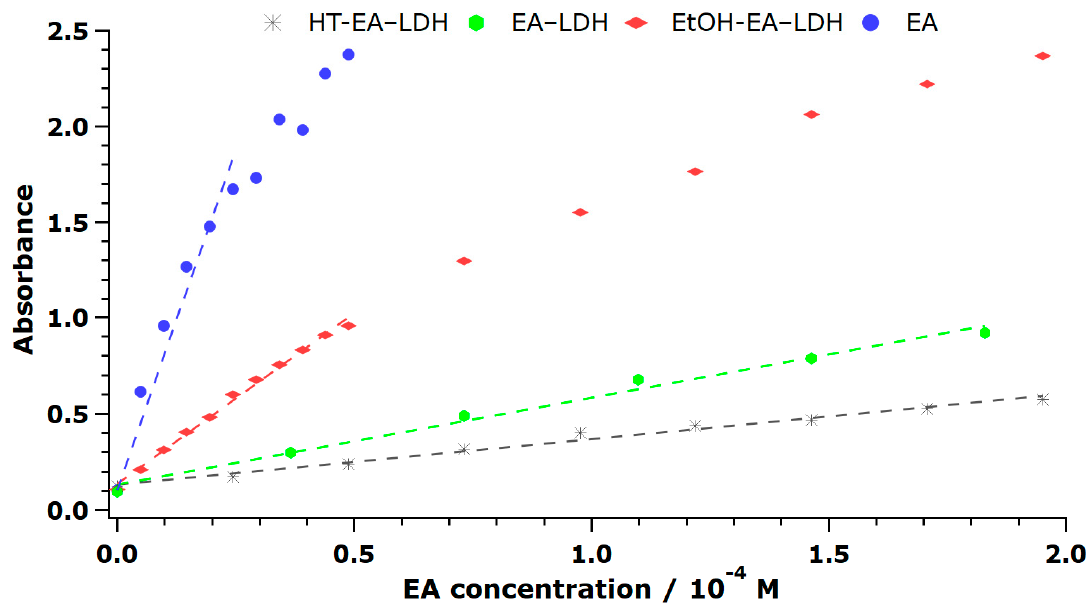
Figure 8. Formation of Cu(I)Nc 2 complex, followed by the EA concentration dependence of the absorbance values. The measurements have an error of about 4%.